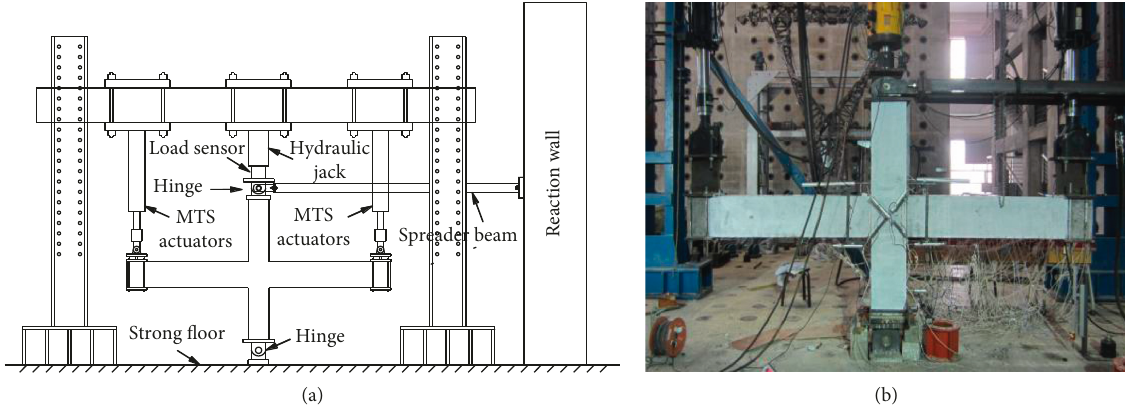
Figure 2: Test setup. (a) Schematic diagram of the test loading device and (b) field